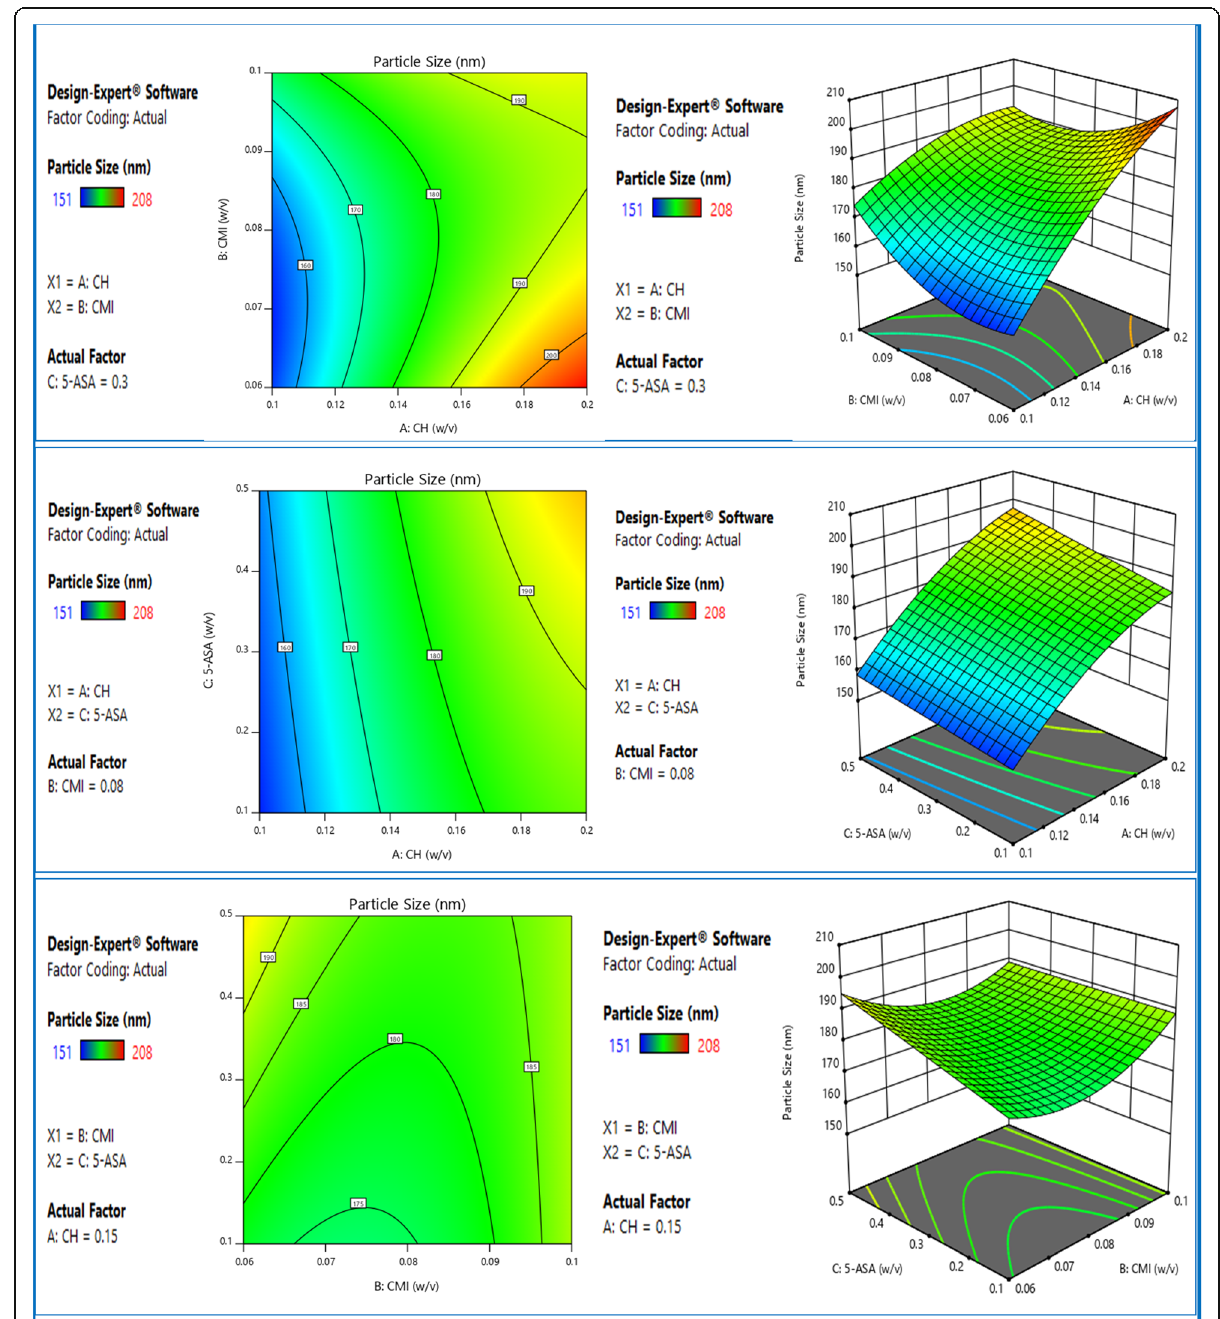
Fig. 3 2D-contour plots and 3D-response surface plots presenting the effect of independent variable on response particle